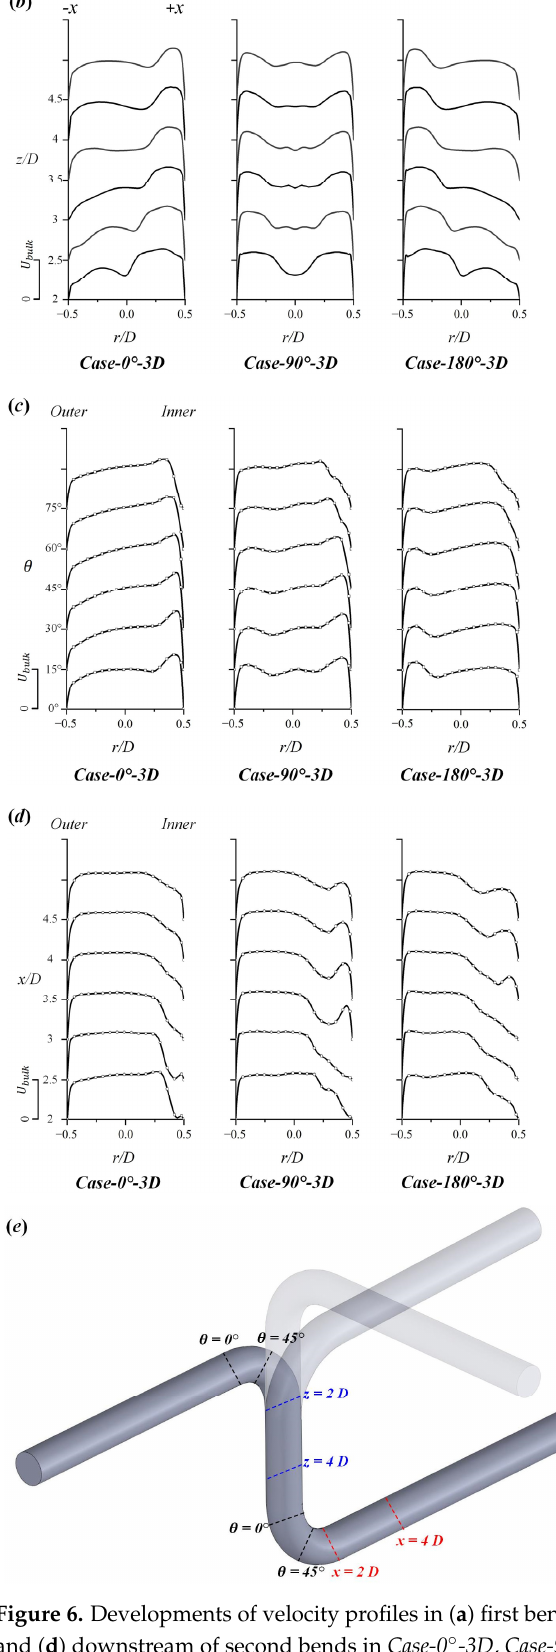
Figure 6. Developments of velocity profiles in ( a ) first bends, ( b ) intermediate pipe, ( c ) second bends, and ( d ) downstream of second bends in Case-0°-3D , Case-90°-3D , and Case-180°-3D , and ( e ) locations of selected profiles.